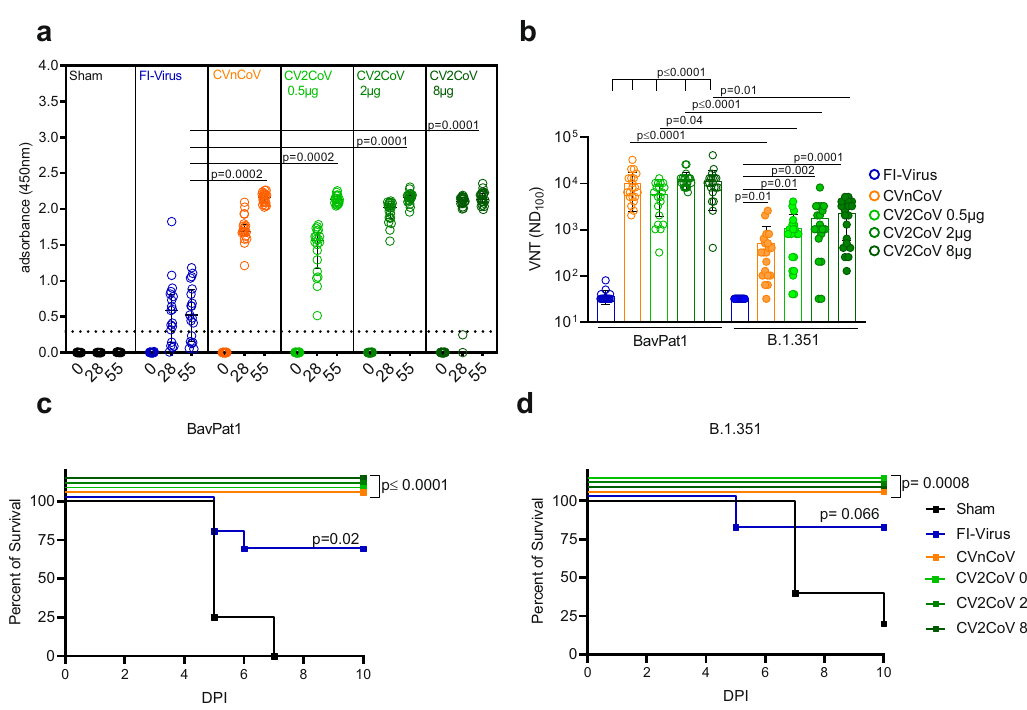
Fig. 1 CVnCoV and CV2CoV protect K18-hACE2 mice against SARS-CoV-2 variants BavPat1 and B1.351. K18-hACE2 mice that were vaccinated with 8 µ g CVnCoV (orange) or different concentrations of CV2CoV (0.5 µ g (light green), 2 µ g (green), or 8 µ g (dark green)), received 10 6 FI-Virus (blue) or NaCl (black) (sham) on days 0 and 28 followed by i.n. challenge with 10 5.9 TCID 50 of SARS-CoV-2 variant BavPat1 or 10 5.5 TCID 50 B1.351. a RBD ELISA with sera from K18-hACE2 mice on days 0, 28, and 55 of the respective groups: median and interquartile range are presented. Dashed line indicates threshold for positive anti-RBD antibody level. b Virus neutralization assay using day 55 sera from all the groups. Bars indicate mean with SD. c , d Survival curves (Kaplan – Meier) for K18-hACE2 mice from all the groups challenged either with BavPat1 ( c ) or B.1.351 ( d ) and followed up for 10 days post infection (DPI). a , b Each dot represents one individual mouse sample. Each sample was tested once (RBD ELISA) or in triplicates (VNT), and assays were repeated at least once. c , d Each line represents groups of mice as shown in a , b from a single experiment ( n = 5 sham, n = 10 all other groups). p Values were determined by nonparametric one-way ANOVA and Dunn ’ s multiple comparisons test ( a , b ) or two-sided log-rank (Mantel – Cox) test ( c , d ). Differences were considered signi fi cant at p < 0.05 with exact p values displayed in the fi gure. Source data are provided as a Source data fi